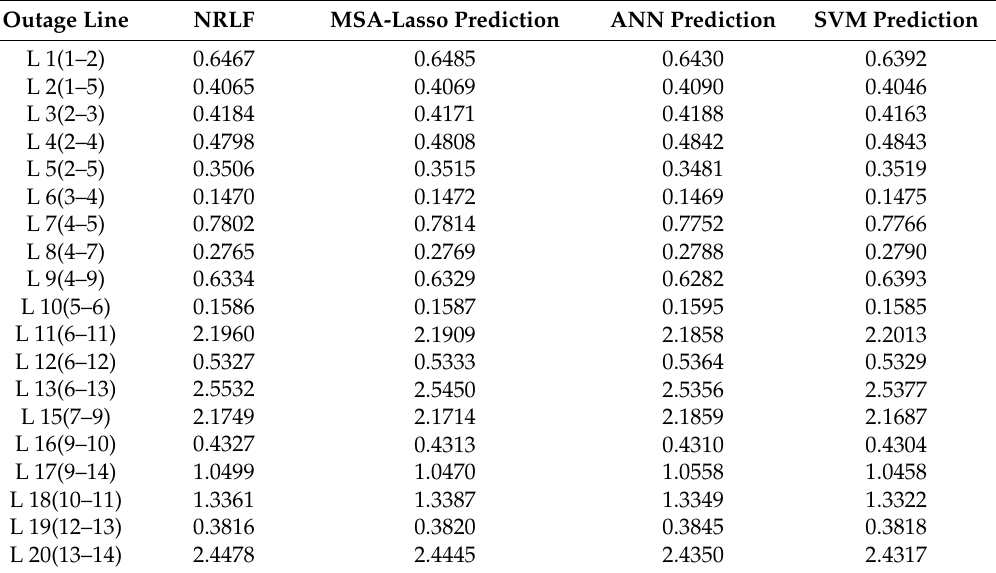
Table 7. Security index results of each method in the base load condition of the IEEE 14-bus system. Outage